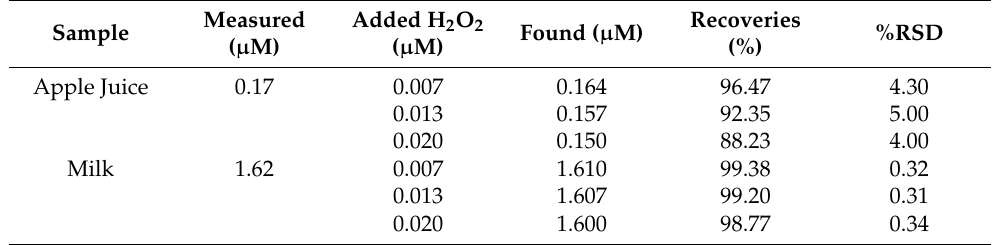
Table 3. Recovery and precision data for hydrogen peroxide determination in milk and apple juice samples in phosphate buffer solution at GCE ‐ SiO ‐ CeONPs.